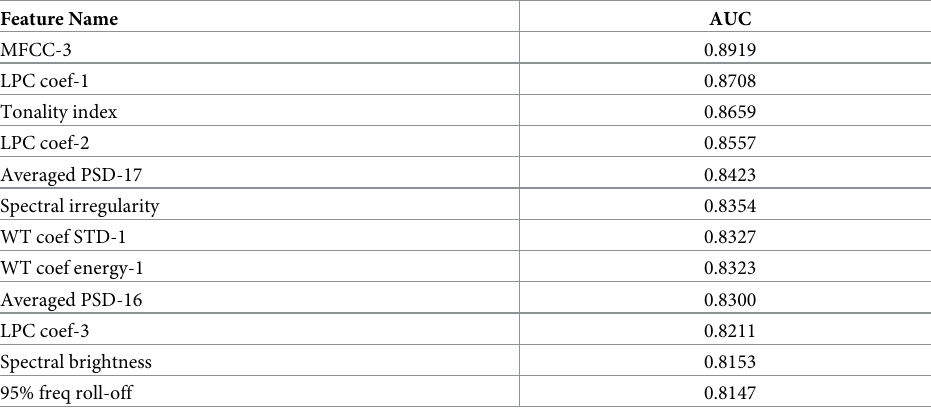
Table 2. AUC comparison of best performing features on all dataset using linear classifier.